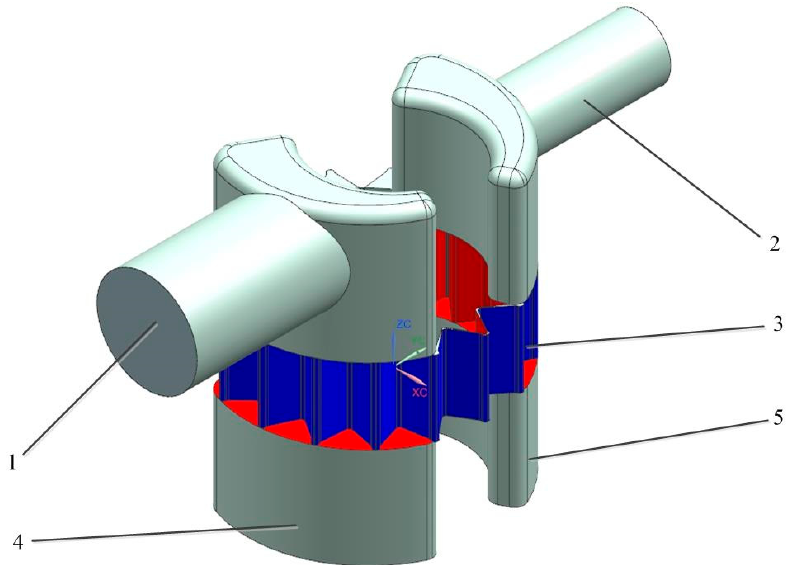
Figure 10. Flow channel model of the straight line conjugate internal meshing gear pump: 1–oil absorption area; 2–oil discharge area; 3–rotor area; 4–oil distribution area on the absorption side; 5–oil distribution area on the discharge side.